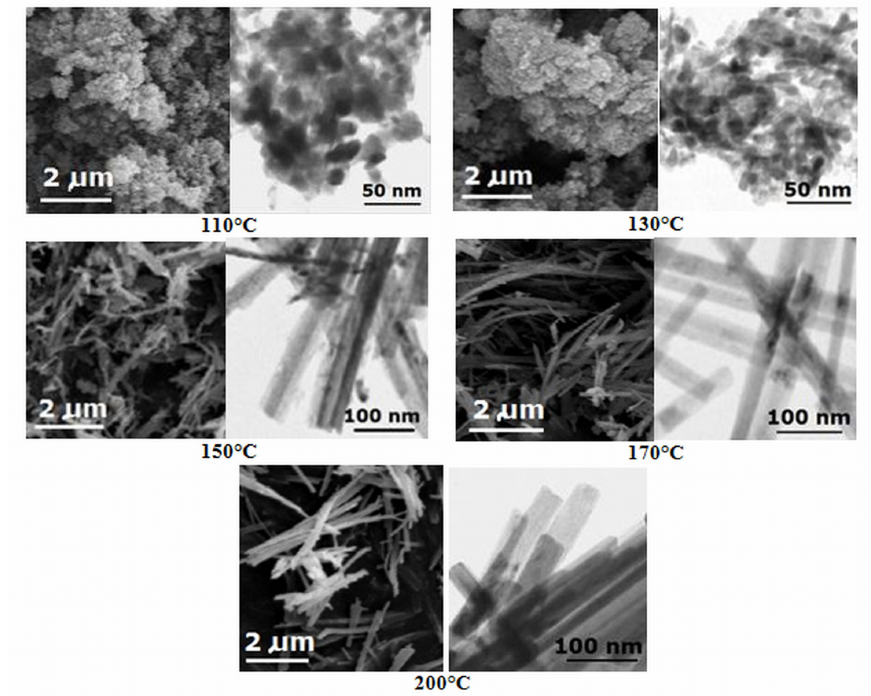
Figure 3: SEM (left) and TEM (right) of materials prepared at different temperatures.